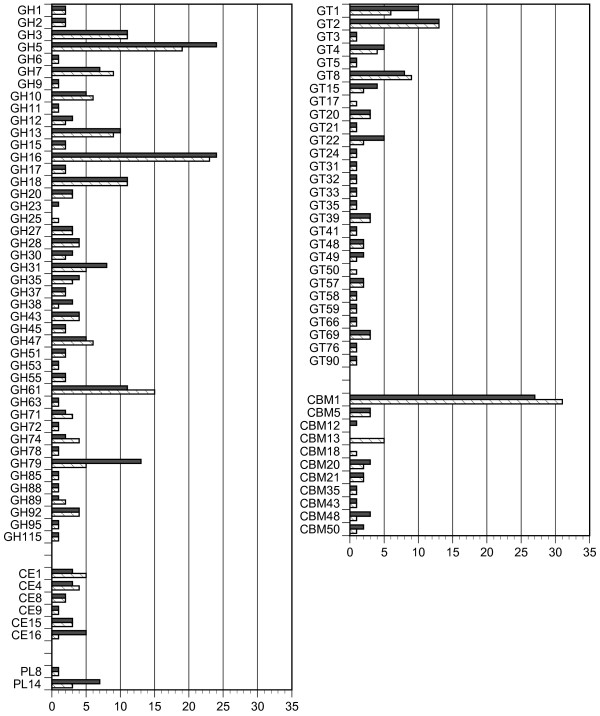
Distribution of CAZymes in P. carnosa (shadowed) and P. chrysosporium (lined).